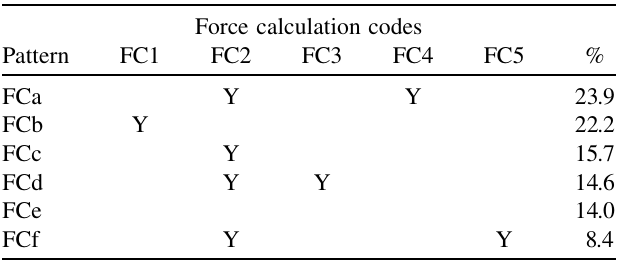
TABLE IV. Only six of the nine distinct code patterns for the FC category (Table II) were populated by more than 3% of the students. The patterns (FCx) are given by affirmatives (Y) and negatives (blank) in the code columns (FC#). The